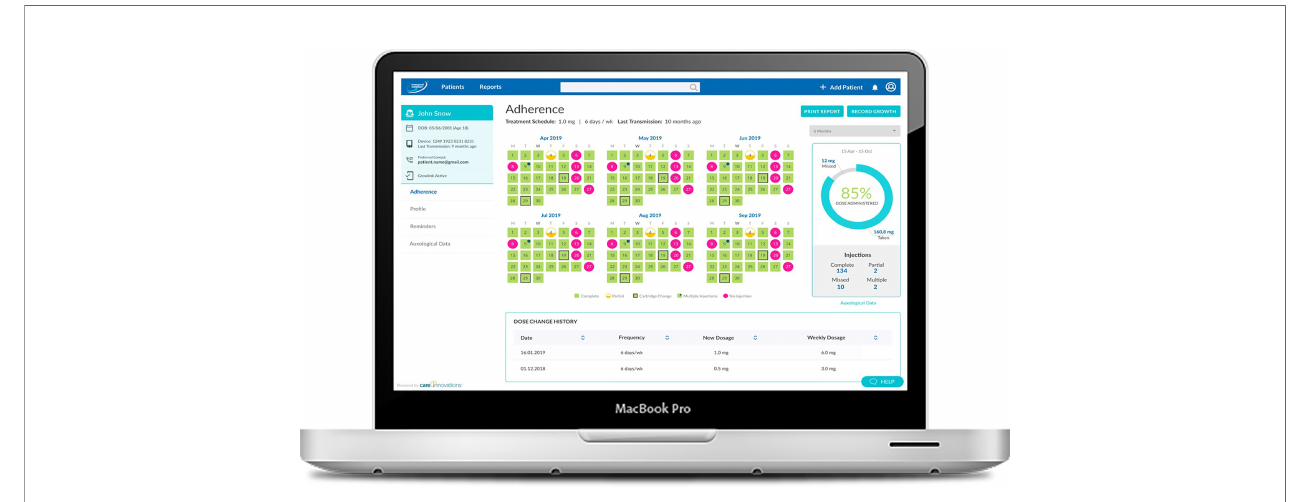
FIGURE 2 | Physician views of the easypod ™ connect